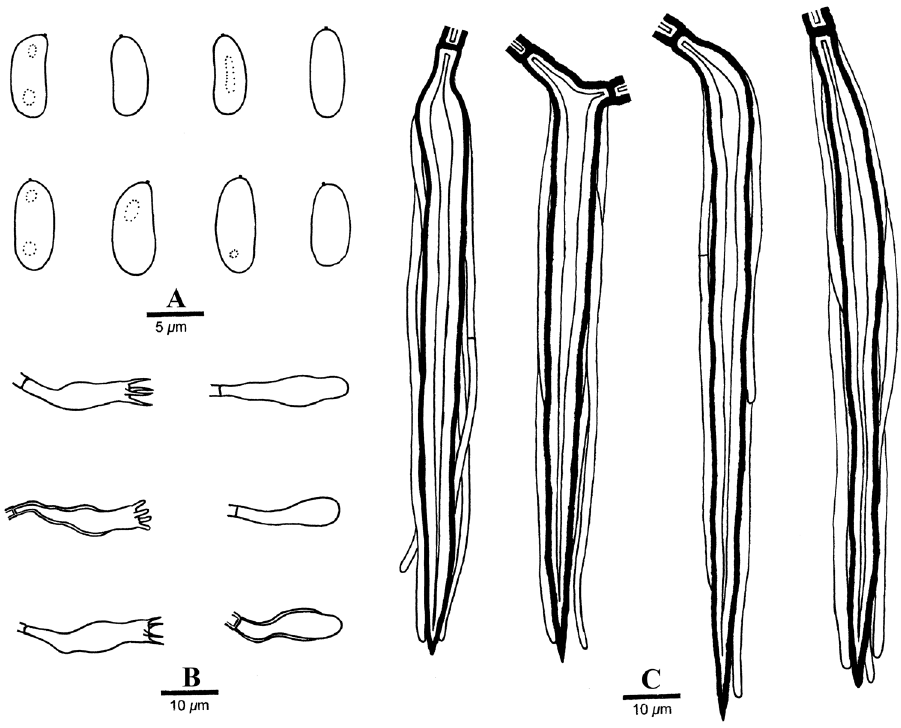
Figure 5. Microscopic structures of Hymenochaete orientalis (drawn from holotype). A Basidiospores B Basidia and basidioles C